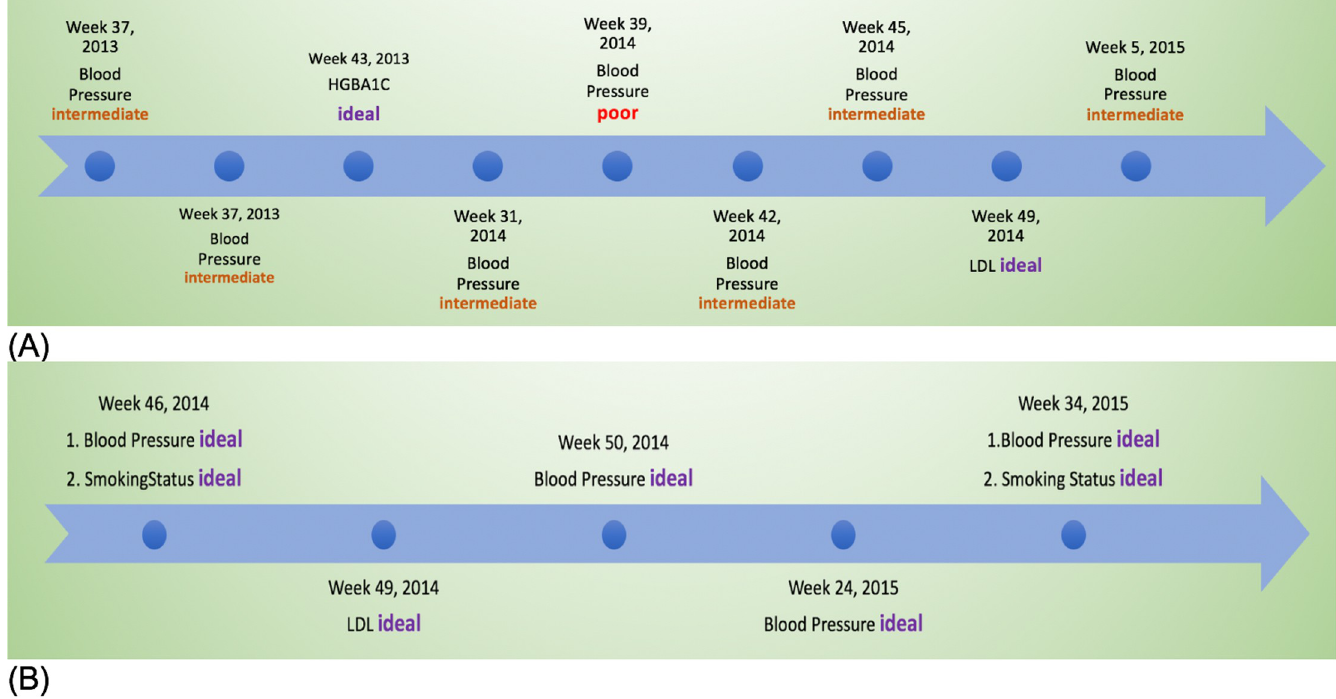
Fig 2. Examples of CVH time series data. (A) Patient was diagnosed with CD; (B) Patient not diagnosed with CD.